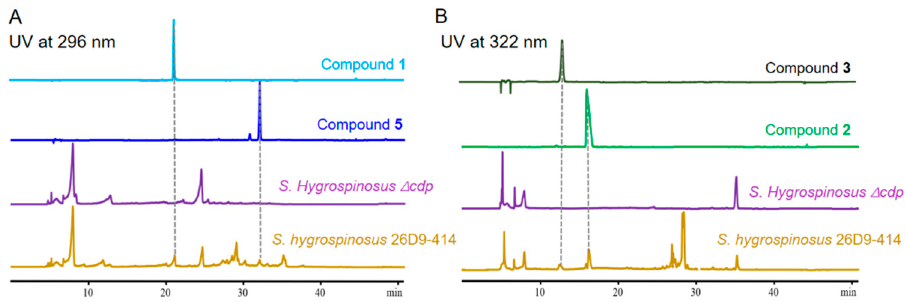
Figure 5. HPLC analysis of metabolites in S. hygrospinosus 26D9-414 and in mutant S. hygrospinosus ∆ alb. ( A ) The UV detection of piperazines were performed at 296 nm; ( B ) The UV detection of pyra- zinones at 322 nm.